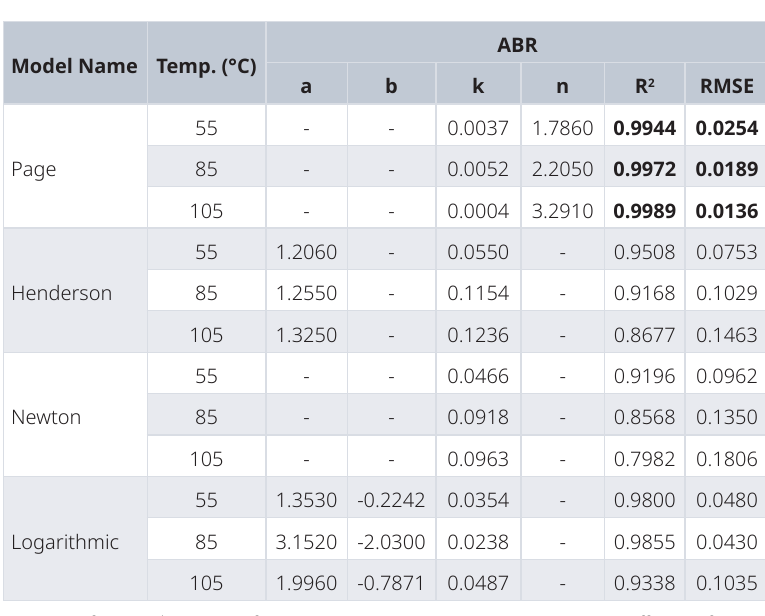
Table 3. Statistical data for isothermal drying of anaerobic baffled reactor (ABR).